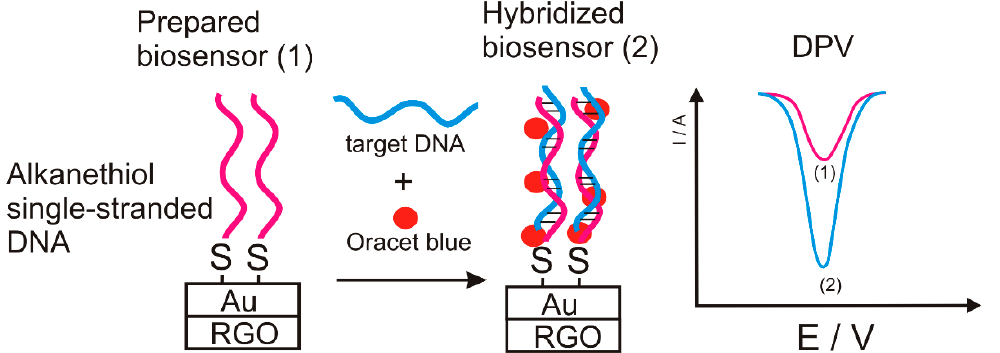
Sensors 2020 , 20 , x FOR PEER REVIEW Figure 12. Nano ‐ biosensor detection scheme. Figure 11. Nano-biosensor detection scheme.